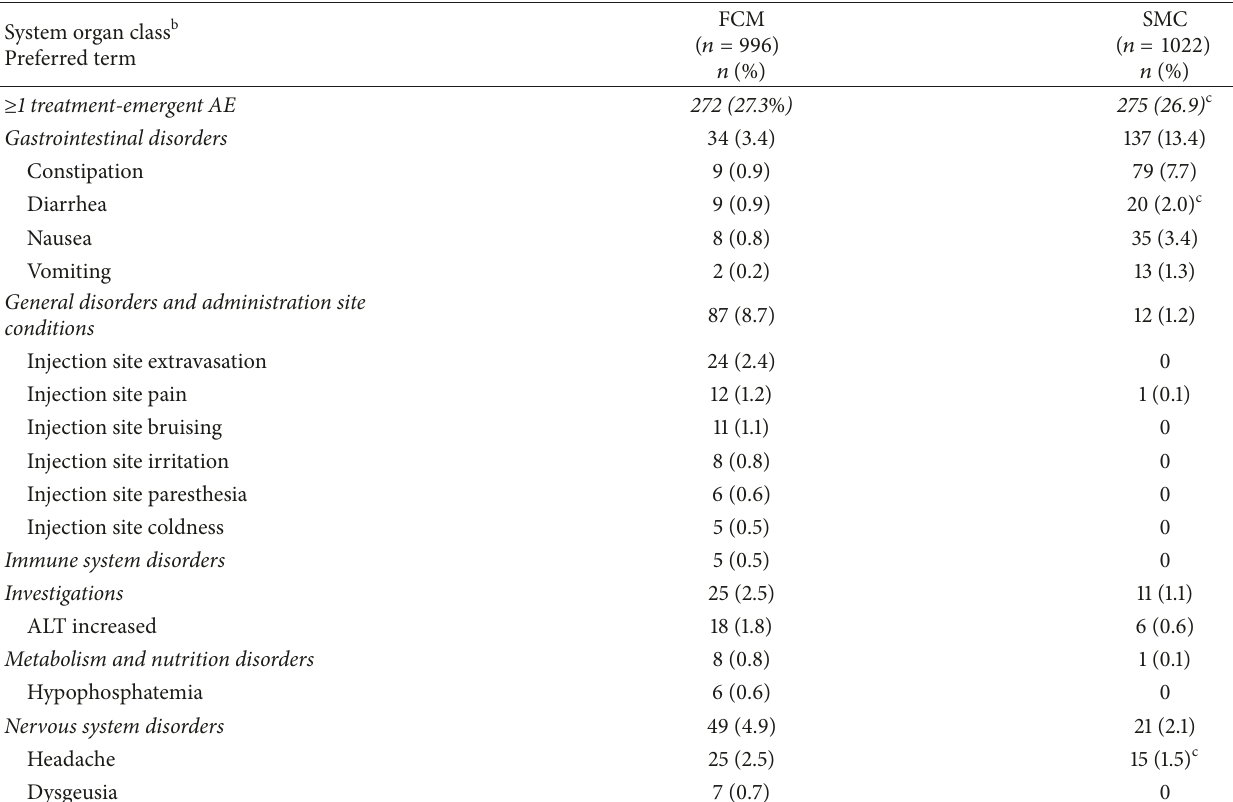
difference between the FCM and SCM treatment groups (safety